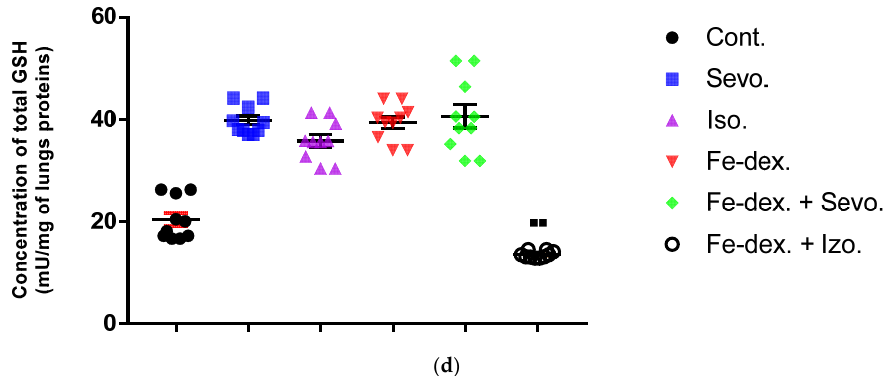
Figure 10. Effect of inhaled anesthetics and iron dextran on MDA ( a ), CAT activity ( b ), SOD activity ( c ), and GSH ( d ) in the lungs of rats treated for 28 days. Rats ( n = 10 per group) were treated with ip injection of iron dextran (50 mg/kg), exposed to 2.4 vol % sevoflurane inhalation and 1.3 vol % isoflurane inhalation, and exposed to a combination thereof where inhaled anesthetics were given 2 h after ip injection of iron dextran. Animals were treated every other day for 28 days. Each animal sample is indicated by a single dot. The results are expressed as the mean value of each experimental group ± SE. * Statistically significant compared to the control group (* p < 0.05; ** p < 0.01; *** p < 0.001); ■ Statistically significant compared to the sevoflurane group ( ■ p < 0.05; ■■ p < 0.01; ■■■ p < 0.001). Other statistically significant changes exist in: ( d ) GSH activity (mU/mg of lungs proteins)—Fe-dex. vs. Fe-dex. + Iso. ( p < 0.01); Fe-dex. + Sevo. vs. Fe-dex. + Iso. ( p < 0.01) Abbreviations: Cont., control group; Sevo., sevoflurane group; Iso., isoflurane group; Fe-dex., iron dextran group; Fe-dex. + Sevo., group treated with iron dextran and sevoflurane; and Fe-dex. + Iso., group treated with iron dextran and isoflurane.